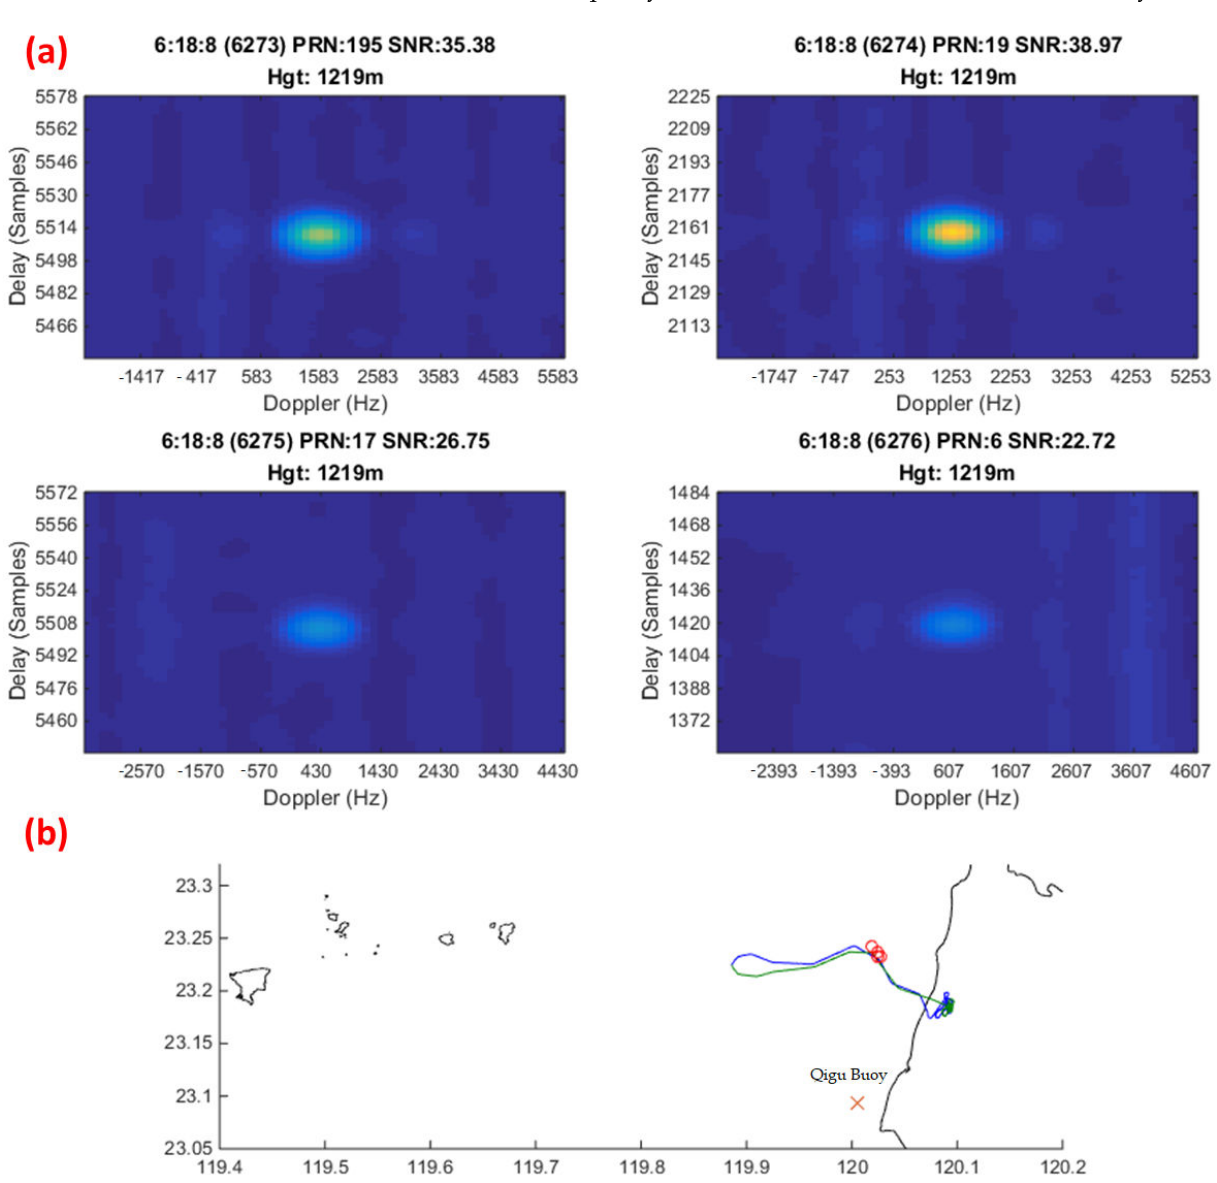
Figure 12. ( a ) One snapshot of the four DDMs ( b ) Four corresponding specular point positions (red circle points) at the UAV flight